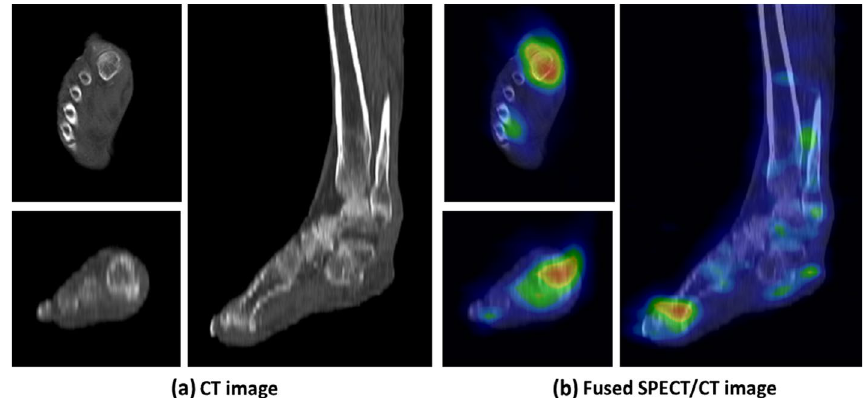
Fig. 3 These images represent a 68-year-old man with diabetic gangrene, hypertension, and atherosclerosis obliterans as comorbidities. a shows CT images indicating increased subcutaneous density and accumulation indicative of cellulitis near the right 1st proximal phalanx, and metatarsal bone with irregular bone destruction, and increased attenuation lesions in the subcutaneous tissue. b shows fused SPECT/CT images indicating distinct accumulation in the subcutaneous tissue, right 1st proximal phalanx and metatarsal bone with high LBR (12.00) and TLU (133.76) and low SUVmax (3.45). The primary physicians diagnosed this patient with CE. The final diagnosis of LLOM was confirmed by the pathologist. The findings indicated sequestrum. Thirty-nine days after the scanning, the patient experienced a fatal event due to